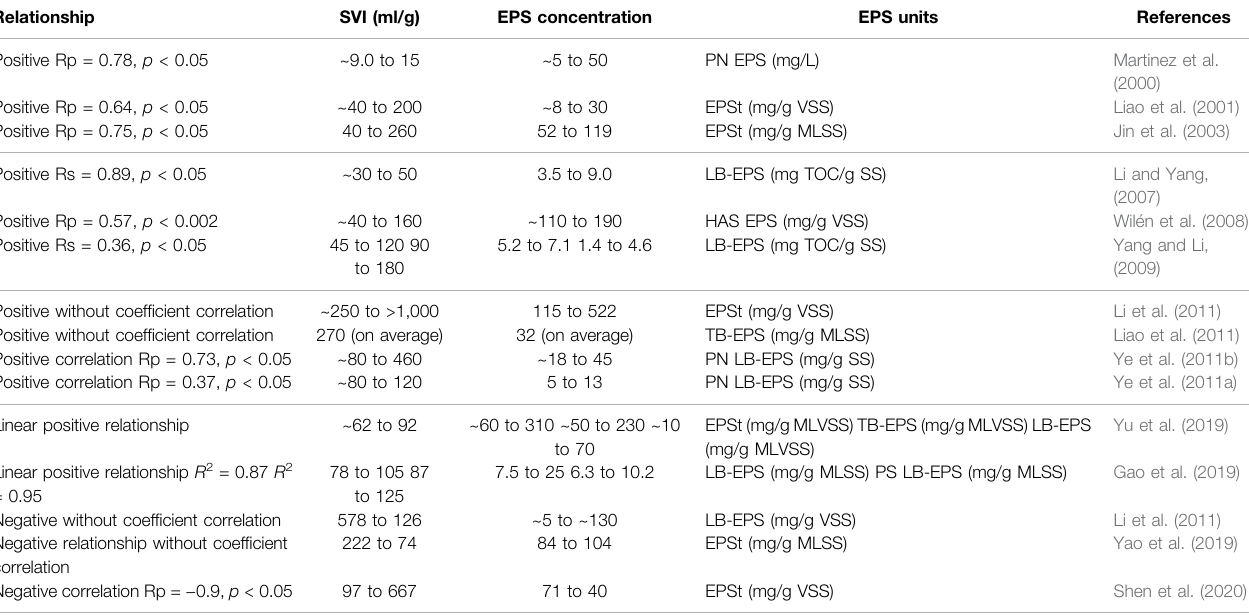
TABLE 1 | Effect of EPS components on the settling ability of microbial aggregates: the relationship between EPS and SVI.